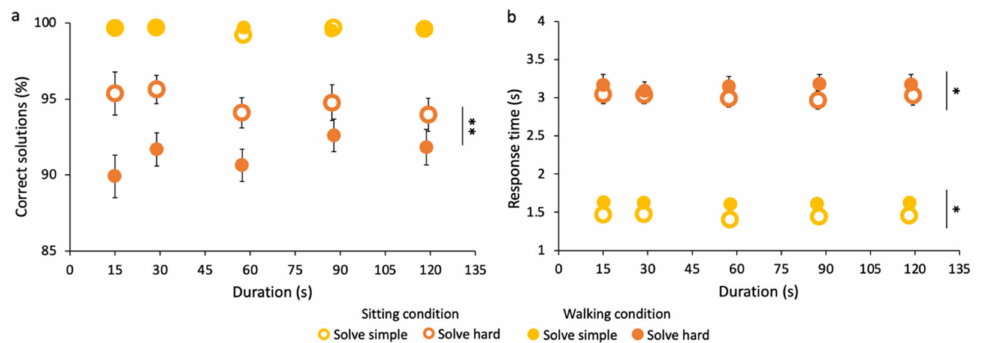
Figure 7. Performance in the math tasks while walking and sitting. ( a ) Percentage of correct solutions. ( b ) Response time to operations. Responses for correct and incorrect solutions are considered. Asterisks mark statistically significant differences with ANOVAs: * p < 0.05, ** p < 0.01. Error bars are SE across